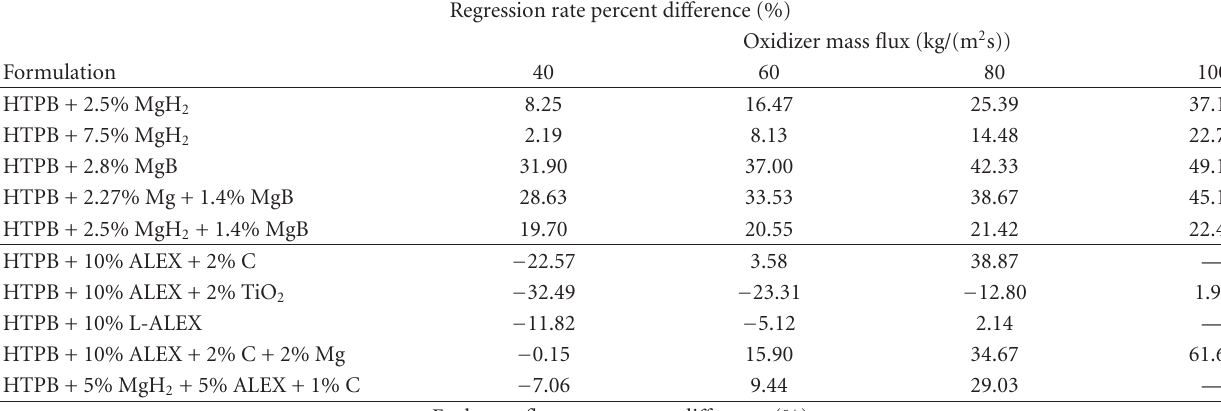
Table 5: Metal-loaded formulations: regression rate and fuel mass flow rate percent di ff erences at discrete values of oxidizer mass flux, compared to